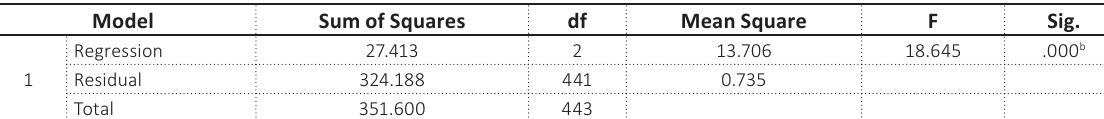
Table 11. ANOVA a for H